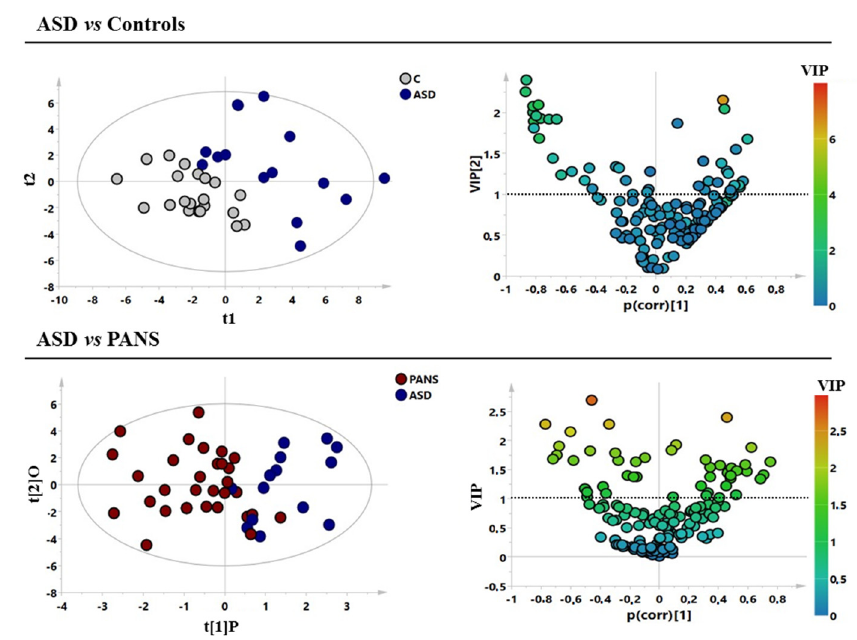
Table 2. Statistical parameters of the multivariate models and the respective permutation test.